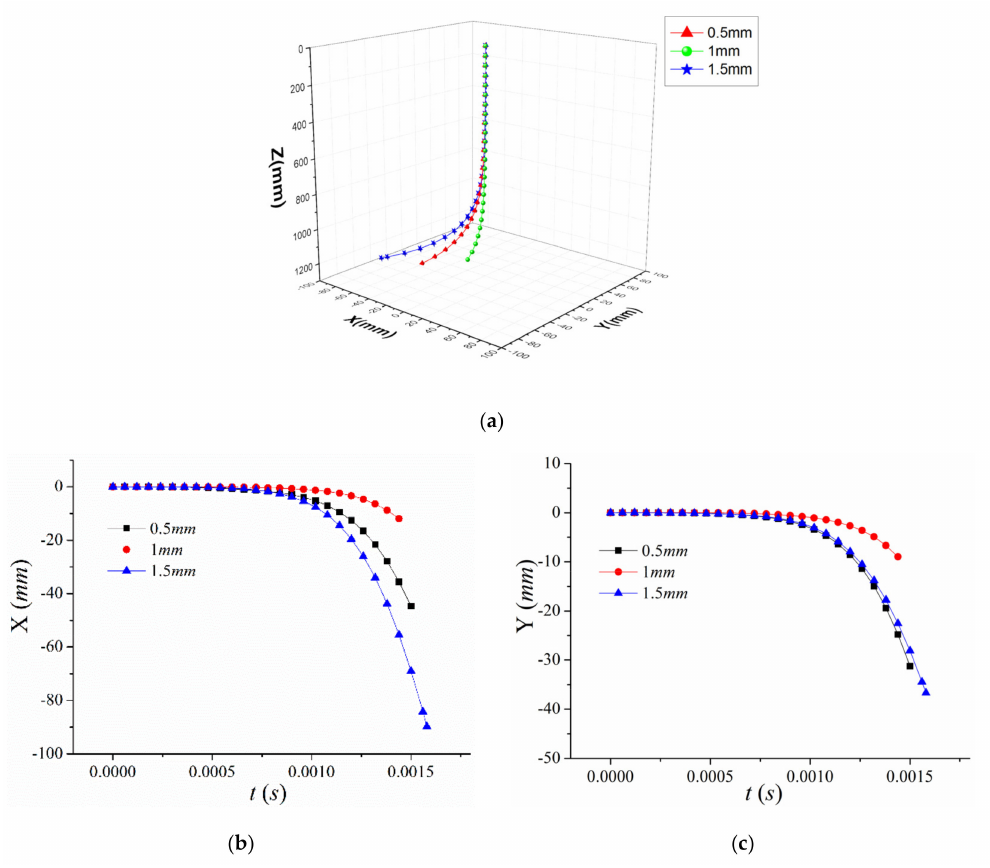
Figure 20. Centroid trajectory of projectile with di ff erent r : ( a ) 3D centroid trajectory; ( b ) Centroid deflection along X direction; ( c ) Centroid deflection along Y